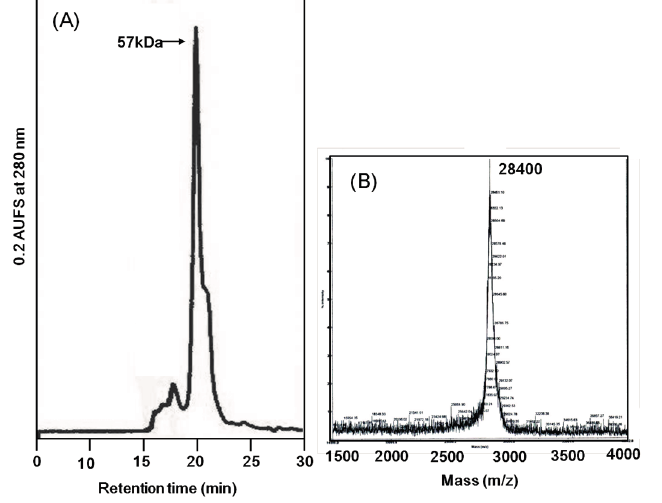
Figure 3. Molecular mass determination of Apios tuber lectin. ( A ) Size exclusion chromatography on a PC200S (N) column (5 μ m, 7.8 × 300 nm) in 50 mM HEPES (pH 6.9) containing 0.25 M NaCl and 5 mM CaCl 2 as the mobile phase. Flow rate: 0.8 mL/min; UV detection: 280 nm. ( B ) MALDI-TOF mass spectral